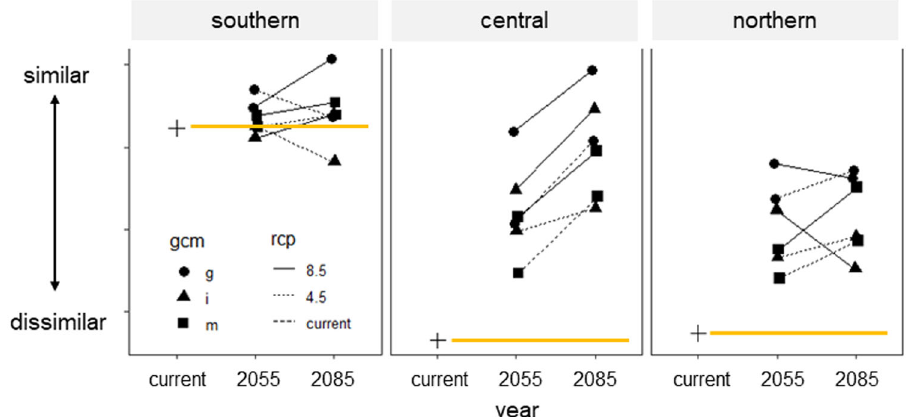
Fig. 3 Changes in similarity for phenological trait distributions across time and relative concentration pathways for each of three genetic provenances of P. angustifolia as predicted by three Atmosphere and Ocean General Circulation/Climate models (AOGCMs). Each point represents an average similarity value for each general circulation model abbreviated as “ i ” (inm-cm4), “ m ” (mpi-esm-lr), and “ g ” (gfdl-cm3). Higher similarity represents a narrow range of phenological trait values. The yellow lines extend from the baseline similarity within each provenance as predicted on climate norms (i.e., extended from the “ current ” value indicated by the “ + ” sign). Values above the yellow line indicate that trait values are becoming more similar over time.